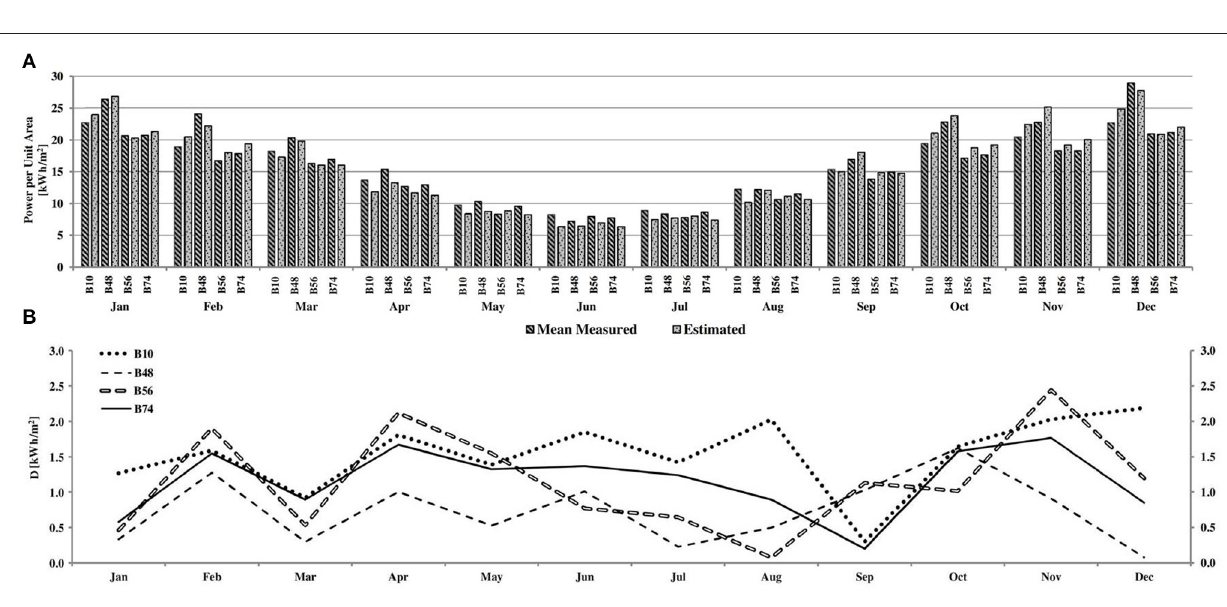
FIGURE 11 | (A) Monthly values for mean measured (P M ) and estimated (P E ) power output per unit area from four building rooftops; (B) the difference in absolute values between P M and P E